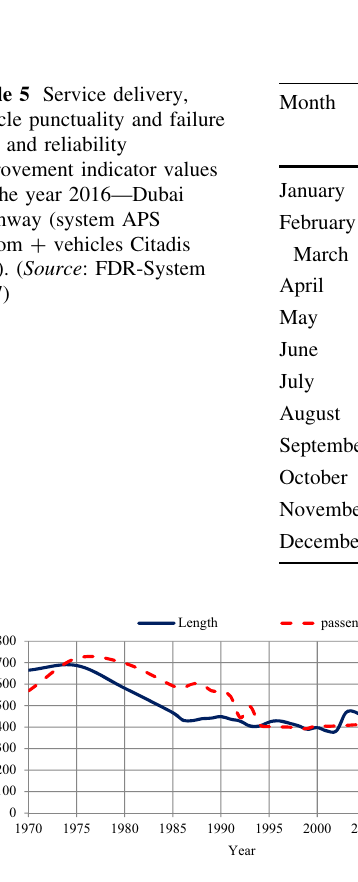
Fig. 3 Tramway lines and passenger expansion in